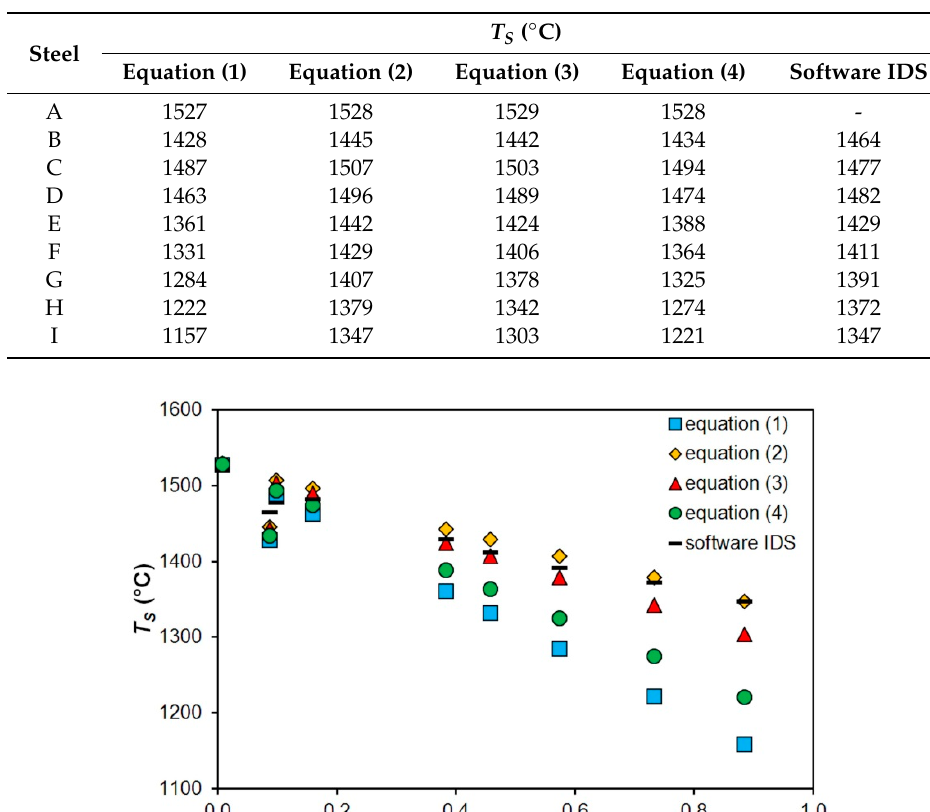
Table 3. Calculated solidus temperatures of the investigated steels.